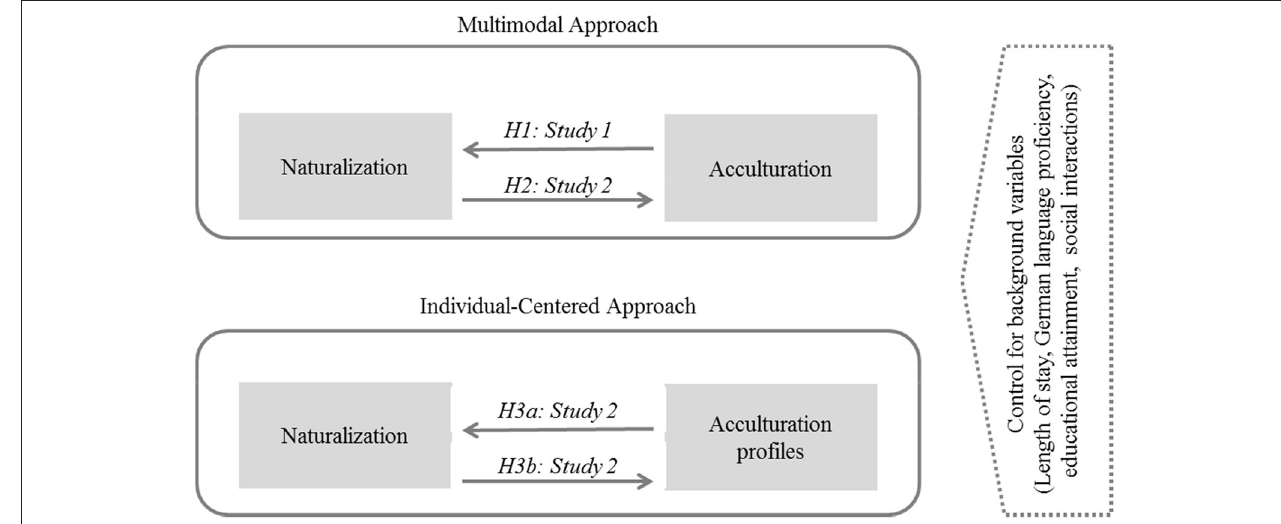
FIGURE 1 | Design to investigate the relationship between naturalization and